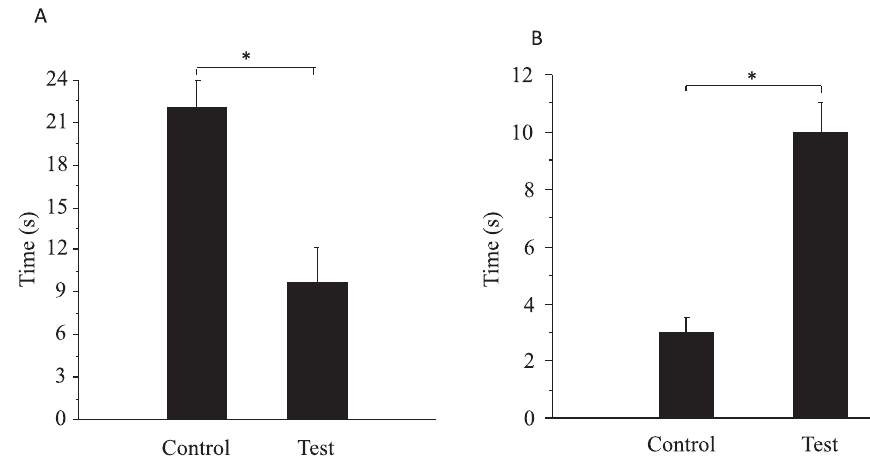
Figure 2 - Effect of mobile phone exposure on time spent in the target quadrant (A) and time taken to reach the target quadrant (B). Mobile phone animals spent less time in the target quadrant and needed more time to reach the target quadrant. Results are expressed as mean ± STDEV.